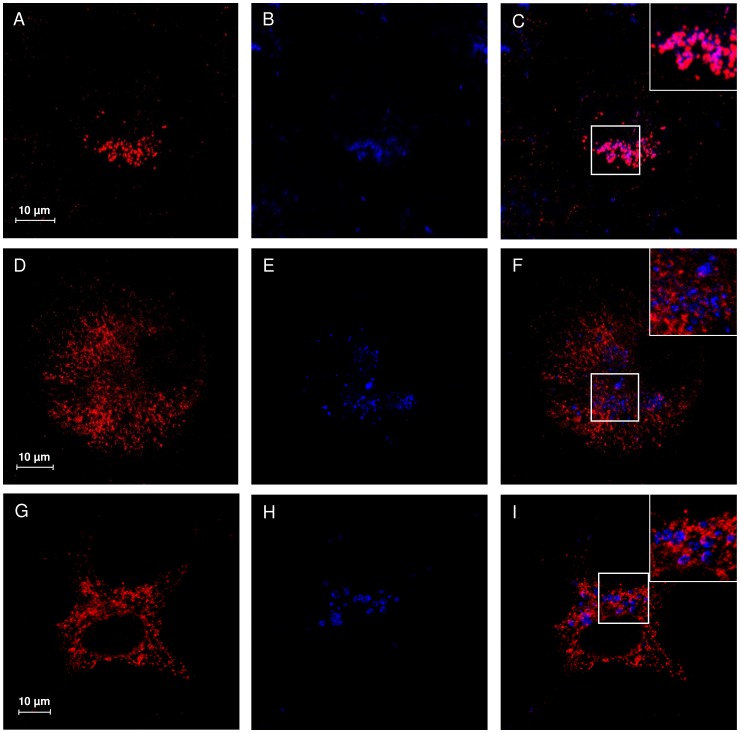
Subcellular localization study of V217A and D234N NEU1 mutant proteins.Confocal microscopy images showing the subcellular distribution of NEU1 wild-type, V217A and D234N mutants. NEU1 proteins were detected using specific rabbit anti-NEU1 antibody and revealed with Alexa-555 secondary antibody. Wild-type NEU1 labeling resulted in a vesicular pattern (A), mainly colocalizing with the lysosomal marker LAMP1 detected with mouse anti-LAMP1 and revealed with Alexa-405 secondary antibody (B, merge in C). The V217A (D) and D234N (G) mutant proteins showed a tubulo-reticular localization. Almost no colocalization between V217A and D234N mutants and LAMP1 (E–F and H–I) could be detected. Insets represent enlargement of the indicated areas.